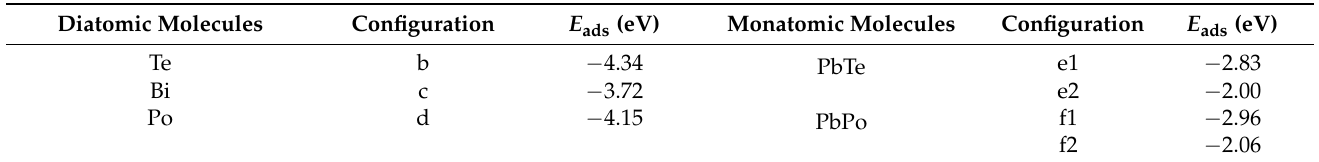
Table 2. Calculated adhesion energies of monoatomic molecules and diatomic molecules on the ≡ Si-O · adsorption